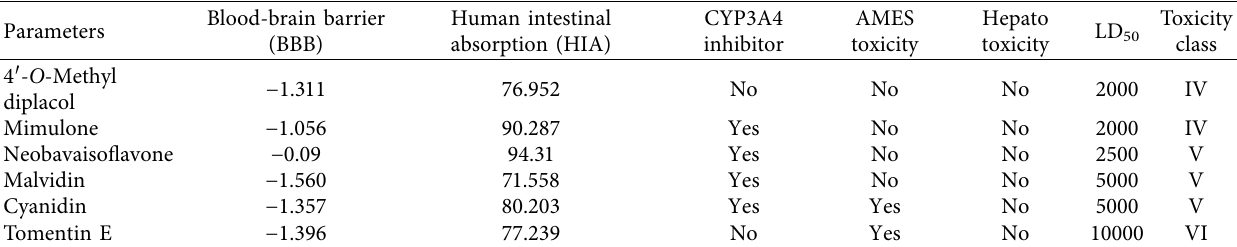
Table 3: ADMET profles of the selected 6 favonoids predicted by using pkCSM and ProTox-II.